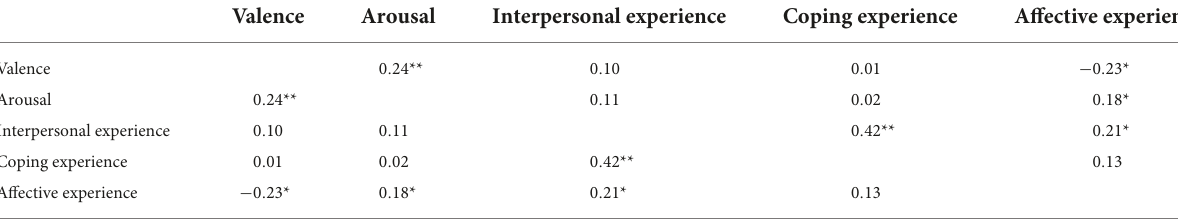
TABLE 3 Correlation between automatically recognized emotion dimensions and processes of